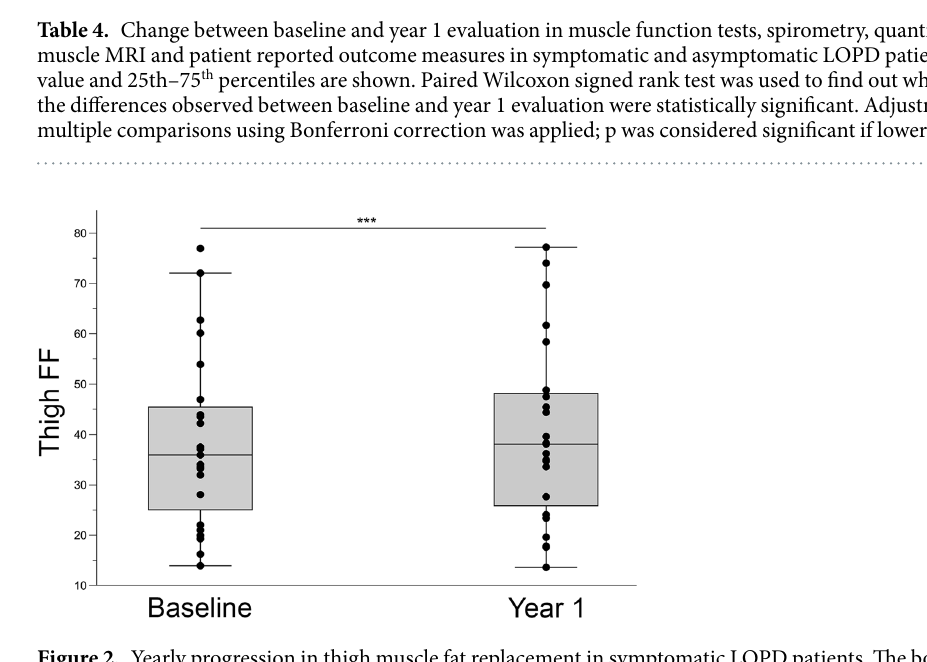
including symptomatic treated patients and asymptomatic patients with hyperCKemia. Our results support the addition of qMRI to the protocol currently used to follow up LOPD patients. In the case of treated patients, qMRI could be useful for analyzing treatment response. For asymptomatic patients, meanwhile, an increase in fat infil- tration detected by qMRI, before clinical symptoms are evident, should be taken into account when considering ERT or a closer follow-up of progression. Hereditary myopathies are characterized by slow progression over the years. Skeletal muscle is replaced by fat and fibrotic tissue leading to muscle weakness 22 . However, annual changes in muscle strength and function can be subtle and difficult to quantify, and it is not uncommon to find a heterogeneous rate of progression among